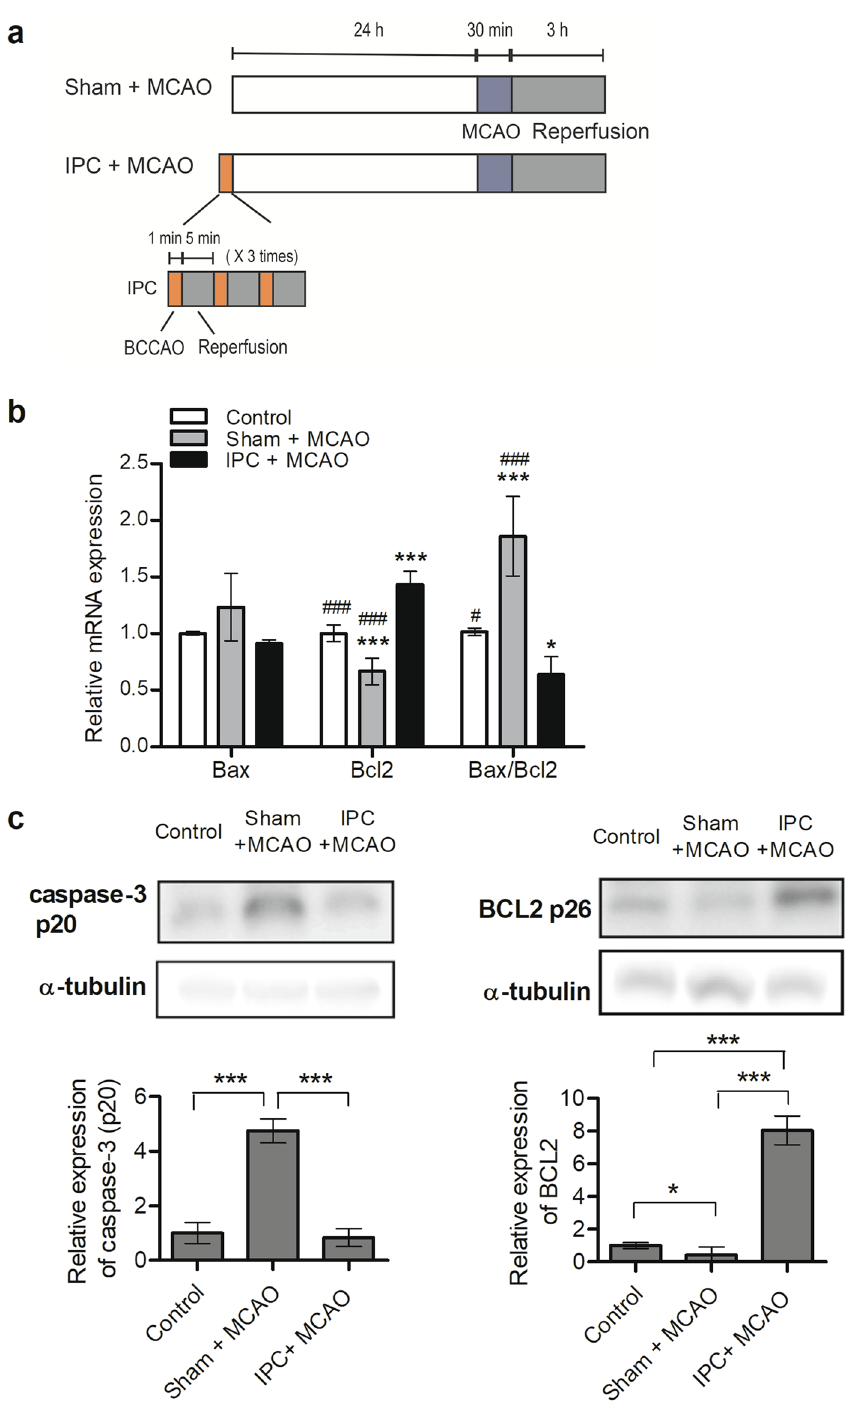
Figure 1. Timeline of experiments and changes to Bax/Bcl2 ratios in ischemic cortex. ( a ) Experimental timeline of Sham + MCAO and IPC + MCAO. IPC was induced by three episodes of 1 min BCCAO with 5 min intervals (n = 6). ( b ) Three hours after reperfusion, the ipsilateral cortex was harvested from MCAO-treated mouse brain, and total RNA was extracted. Bax and Bcl2 mRNA expression was determined by RT-qPCR. Data are represented as mean ± standard deviation (n = 6). Statistical analyses were performed using a one-way analysis of variance and Dunnett’s multiple comparison post-hoc test for comparing the control group (*) or IPC + MCAO group (#) to the other two groups (* = p < 0.05, *** = p < 0.001, # = p < 0.05, ### = p < 0.001). ( c ) Cleaved caspase-3 and BCL2 protein expression was assessed using Western-blot analyses. Values from densitometric analyses are shown after normalization to α-tubulin values from controls. Data are mean ± standard deviation (n = 6). Statistical analyses were performed using t -tests (* = p < 0.05, *** = p < 0.001). Full-length blots are presented in Supplementary Fig. 1. Abbreviations: Bax, Bcl2 associated X; Bcl2, B-cell lymphoma 2; MCAO, transient middle cerebral artery occlusion; IPC, ischemic preconditioning; BCCAO, bilateral common carotid artery occlusion; RNA, ribonucleic acid; mRNA, messenger ribonucleic acid; RT-qPCR, reverse transcription-quantitative polymerase chain